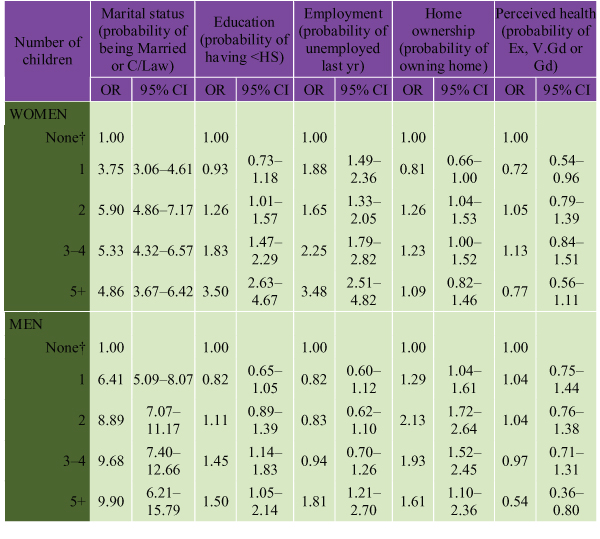
Multivariate Associations Between Number of Children and Specific Factors Linked to Determinants of Health Data Source: GSS Cycle 10, 1995